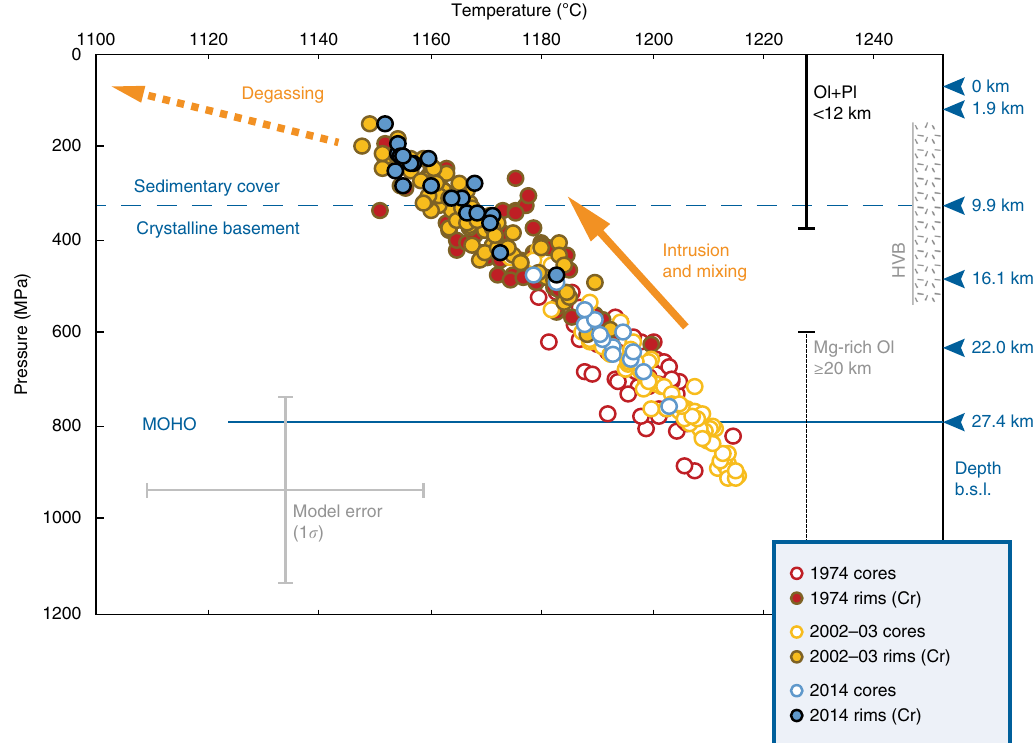
Fig. 4 Clinopyroxene thermobarometry and crustal context below Mt. Etna. Clinopyroxene cores and Cr-rich rims de fi ne a polybaric crystallisation trend, where cores that crystallised at 300 – 900 ± 200 MPa and 1163 – 1216 ± 25 °C were sampled by intruding magmas from which Cr-rich rims crystallised at 200 – 600 ± 200 MPa and 1148 – 1200 ± 25 °C. Input data for P – T calculations are clinopyroxene compositions from the 1974 and 2002 – 2003 eccentric eruption and the 2014 central conduit eruption (Supplementary Fig. 2; Supplementary Data 2), and a representative bulk crystal-poor scoria of the 1974 eccentric eruption 23 . Temperatures were estimated using the pressure-independent, melt-dependent calibration of ref. 76 . Pressures were estimated using the melt-independent, H 2 O-in-melt-dependent, temperature-dependent calibration 32b of ref. 44 . We assumed a conservative H 2 O content in the melt of 2 wt% 17,26 . Depth equivalences of major lithological boundaries are indicated across the crustal stratigraphy 78 : 3 km a.s.l. to 0 km: Volcanics and postorogenic clays, 2.47 g/cm 3 ; 0 – 1.9 km: Marly and argillaceous – arenaceous fl ysch, 2.57g/cm 3 ; 1.9 – 9.9 km: Carbonate rocks, 2.61 g/cm 3 ; 9.9 – 16.1